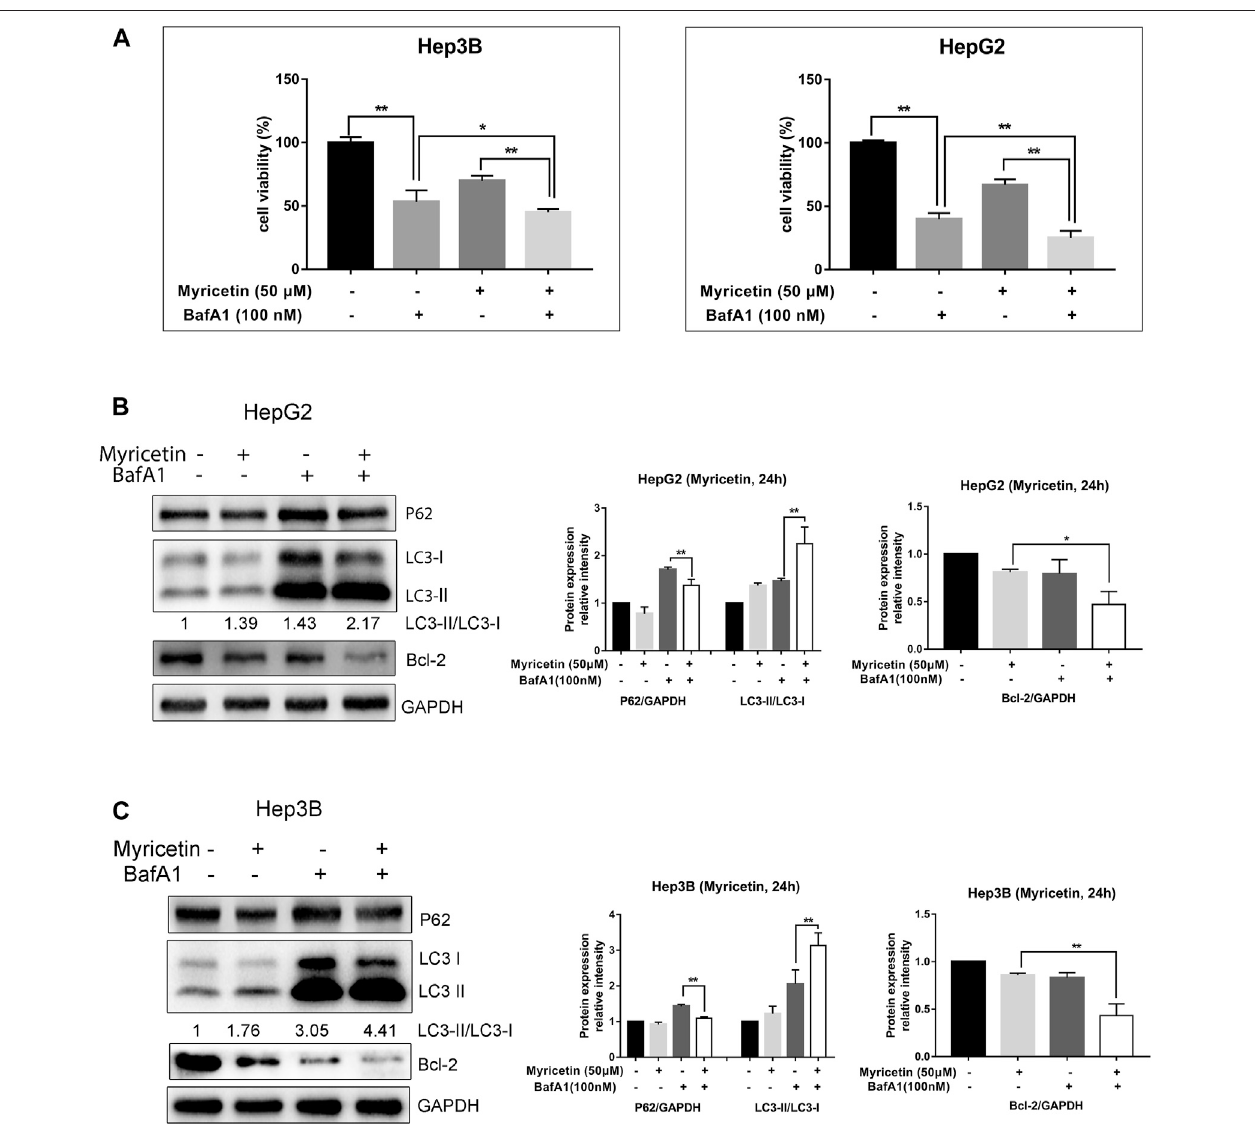
FIGURE 3 | Myricetin synergistically inhibits HCC growth with BafA1. (A) The viability of HCC cells was assessed by CCK-8 reagent under the effect of combination of 50 μ M myricetin and 100 nM BafA1. (B) HepG2 cells were treated with 100 nM BafA1 (pre-treated for 4 h) and 50 μ M myricetin (for 24 h), followed by Western blot to analyze LC3, P62 and Bcl-2 protein. (C) LC3 and P62 expressions in Hep3B cells detected when cells were treated with myricetin and BafA1. Blots analyzed by ImageJ. All data are from results of three experiments, presented as the means ± SD. * represents p < 0.05, ** represents p < 0.01.